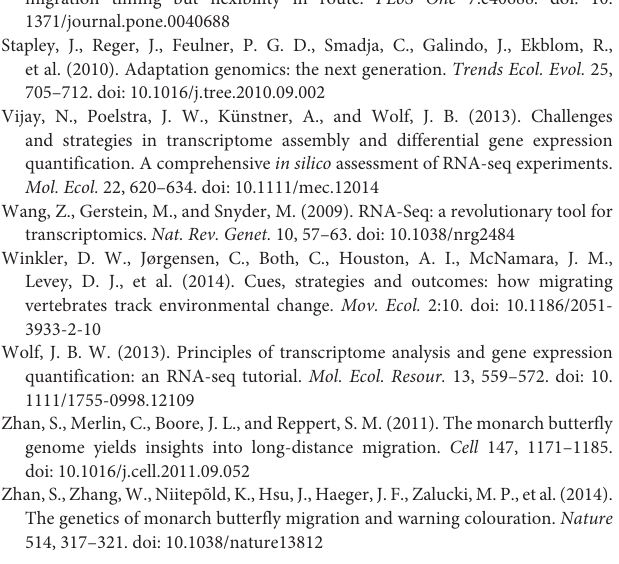
The genetics of monarch butterfly migration and warning colouration. Nature 514, 317–321. doi: